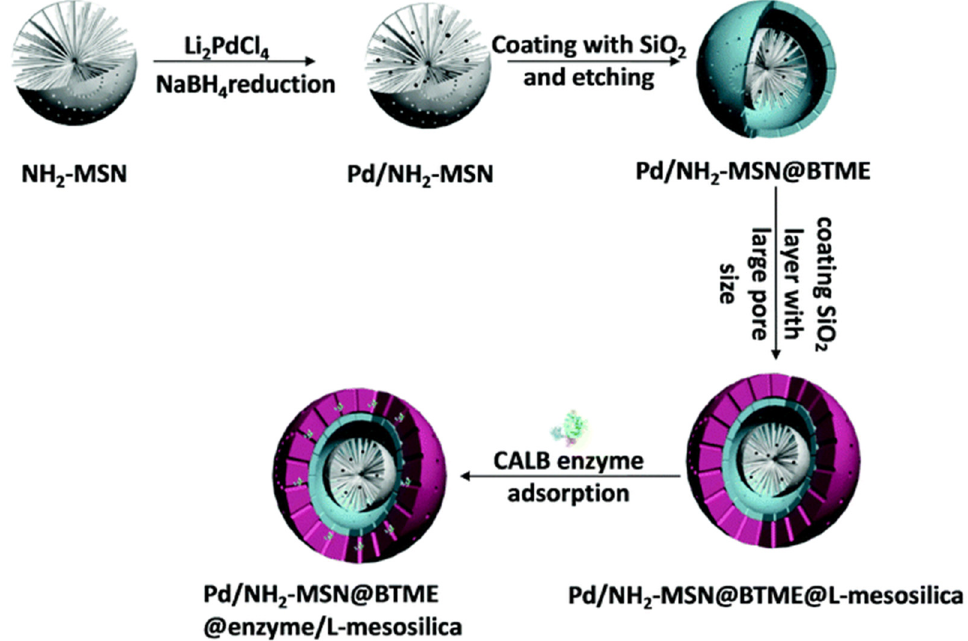
Figure 7. Preparation of a Pd/CAL-B yolk@shell–shell catalyst [175]. Reprinted from [175] with permission of Royal Society of Chemistry.